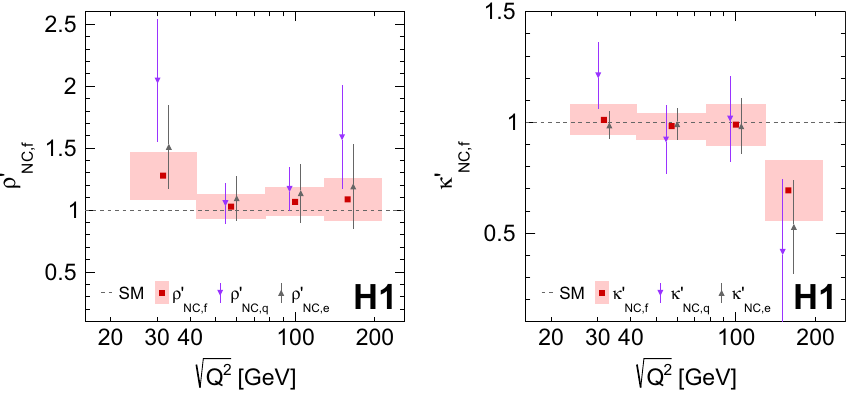
Fig. 7 Values of the ρ (cid:6) ferent values of Q 2 . The error bars, as well as the height of the shaded areas, indicate the total uncertainties of the measurement. The width of